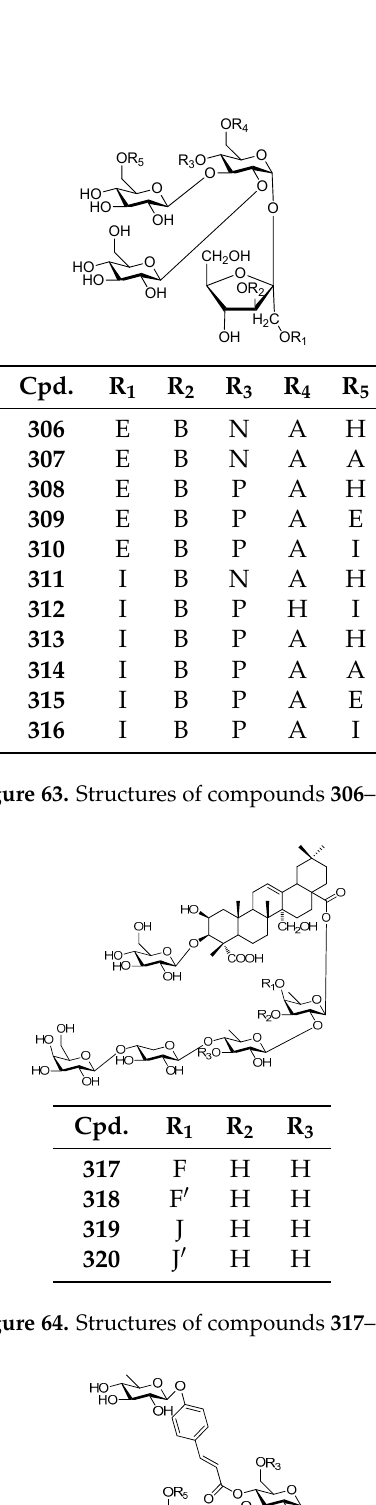
Figure 65. Structures of compounds 321 – 322 .